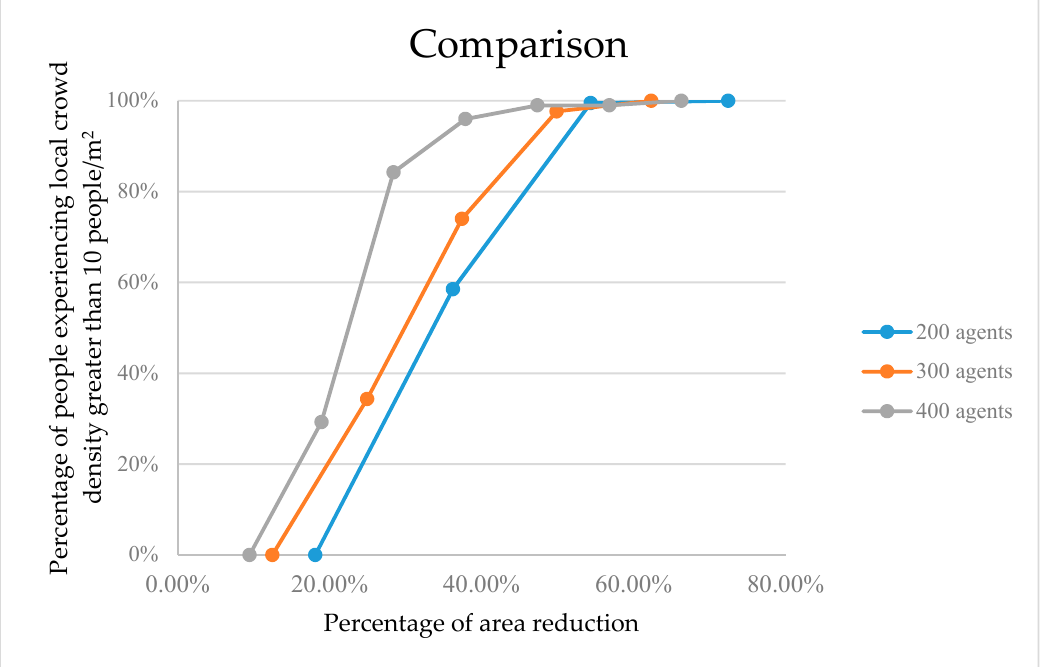
Figure 14. The percentage of people experiencing local crowd density greater than 10 people/m 2 as the occupied area shrinks for the three population sizes.